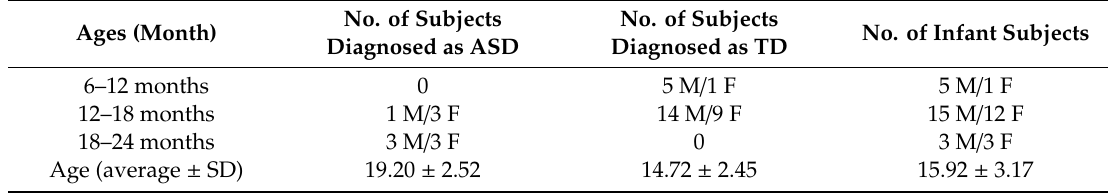
Table 1. Distribution of age and gender (male /